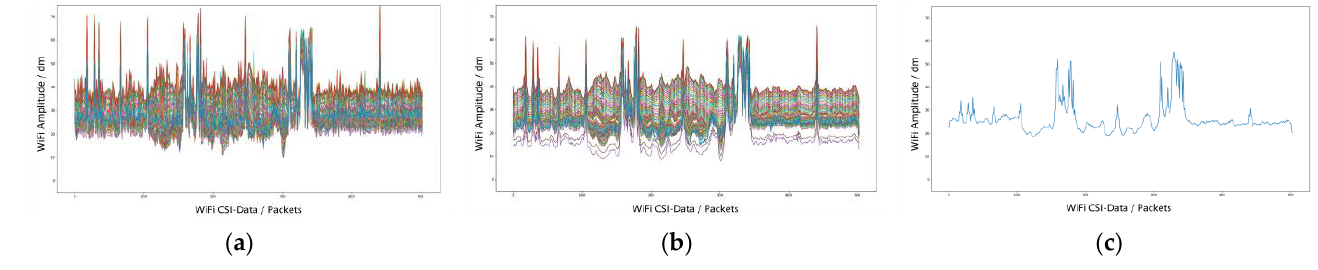
Figure 5. Data processing: ( a ) Raw CSI; ( b ) Noise Reduction CSI; ( c ) PCA.